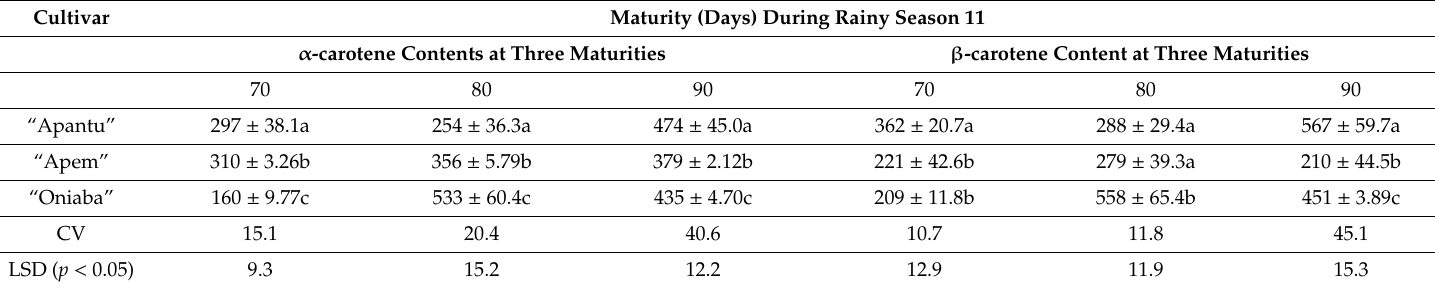
Table 3. Provitamin A active carotenoid levels µ g / 100 g edible pulp) three di ff erent plantain cultivars at maturation and seasonality. Cultivar